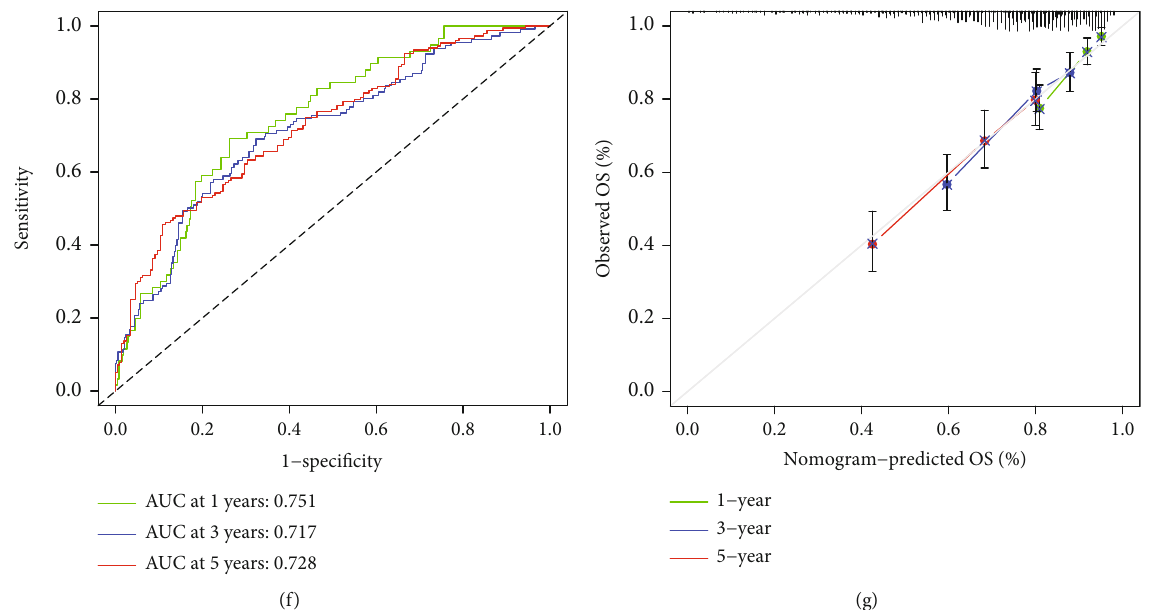
Figure 5: Construction and analysis of IGRPM. (a) Cross-validation for tuning parameter selection in the lasso model. (b) Risk score distribution of KIRC patients in the combined TCGA and GEO cohorts. (c) Distribution of the survival time and survival status in the combined TCGA and GEO cohorts. (d) Correlation analysis of OS and risk score in the combined TCGA and GEO cohorts. (e) Kaplan- Meier survival analysis for di ff erent risk groups in the combined TCGA and GEO cohorts. (f) The 1-, 3-, and 5-year ROC and AUC predicted based on the risk characteristic of IGRPM in the combined TCGA and GEO cohorts. (g) The calibration diagram of IGRPM- based risk characteristic for the combined TCGA and GEO cohorts. OS: overall